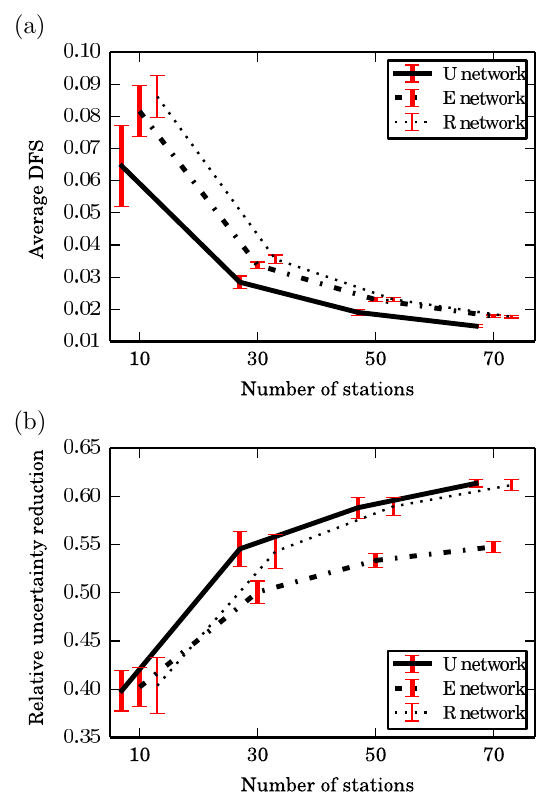
Figure 10. For three types of networks of different sizes, we com- pute (a) the average DFS, which is total DFS divided by the to- tal number of observations assimilated, and (b) the relative re- duction of uncertainties in scaling factor estimates computed by √ −√ √ ( 1 T B 1 1 T A 1 )/ 1 T B 1, where 1 is an all-one vector. The er- ror bars show variations due to inversions using 10 different net- works of same size constructed as detailed in Sect.